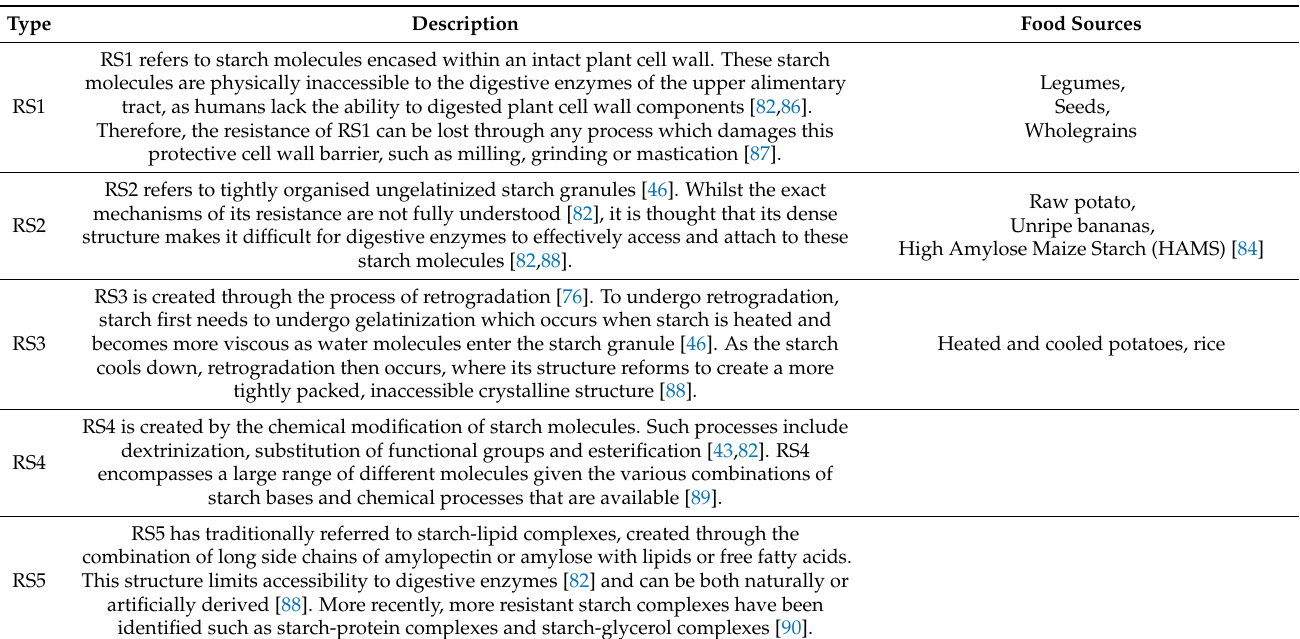
Table 1. Types of Resistant